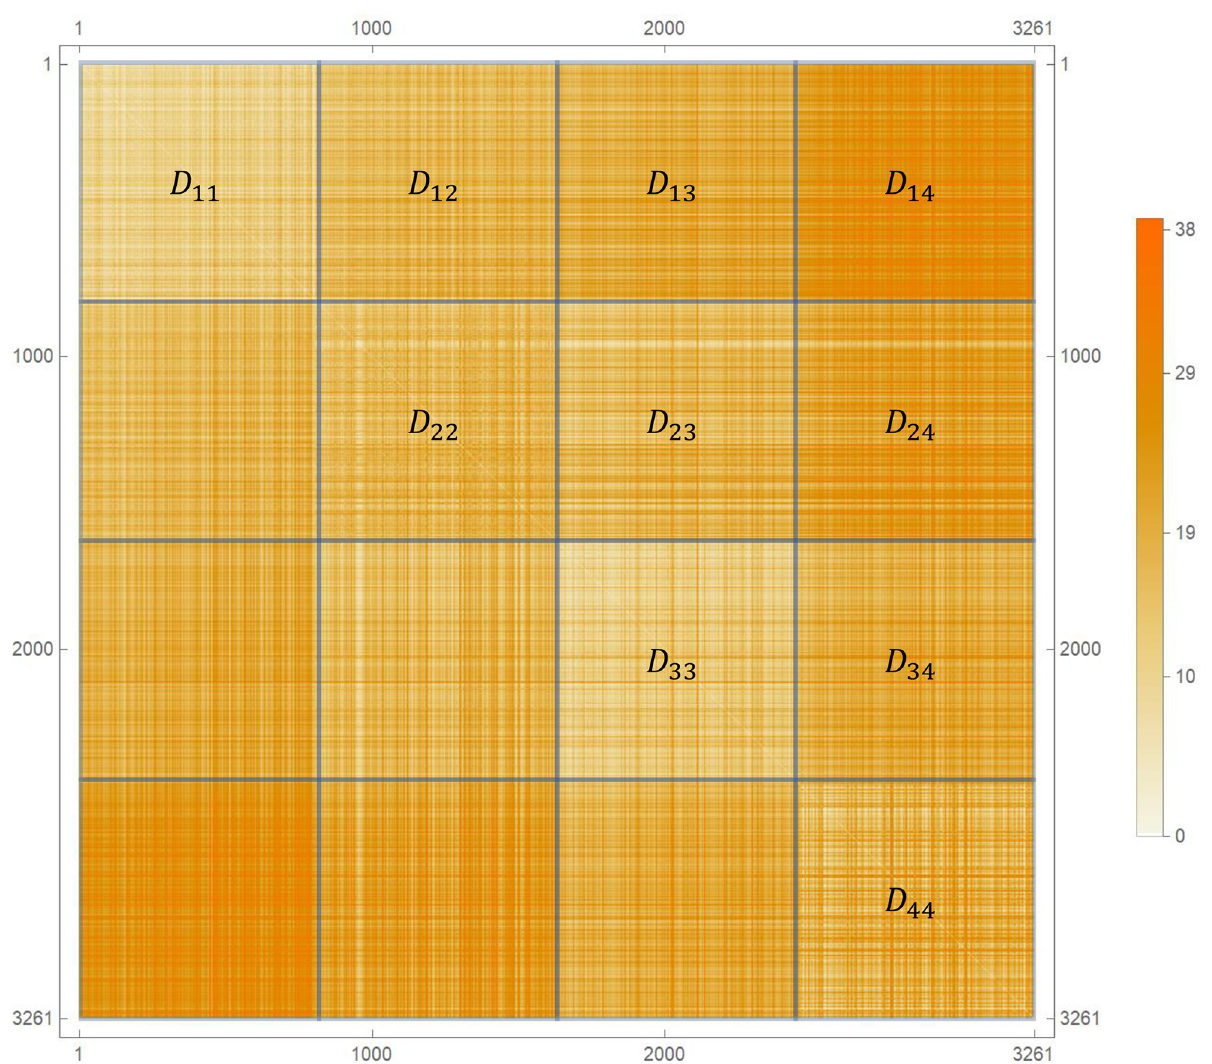
Fig 6. Hamming distance between pairs of viruses. The distance matrix is sorted by the city. Diagonal blocks show the distance between the viruses from a single city, while the non-diagonal blocks are the distances between the viruses from different cities.